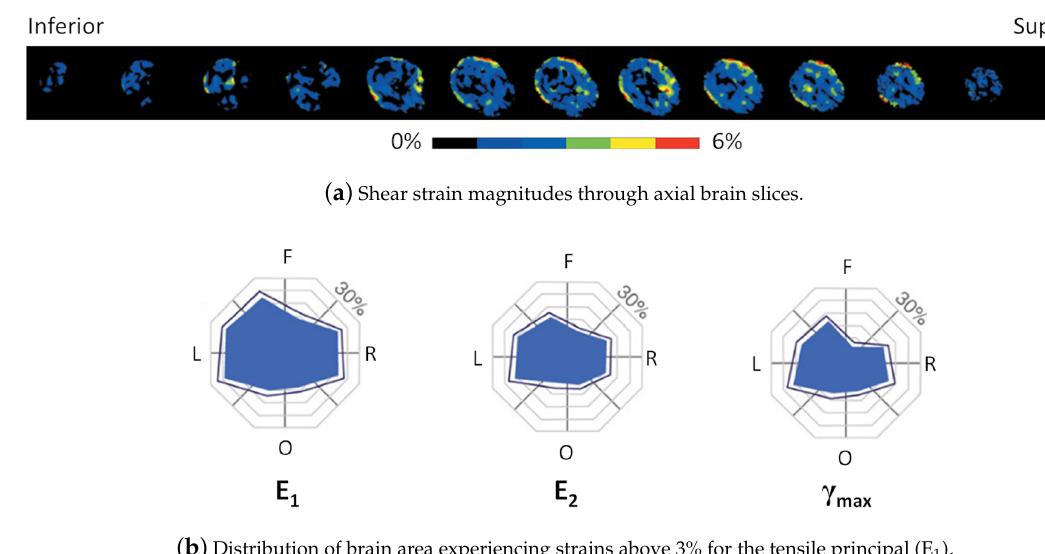
Figure 11. Example of brain strain responses reported by Chan et al. [60], 54 ms after volunteer trigger release. ( a ) Maximum recorded shear strains through 13 axial brain slices moving from inferior to superior regions. The superior most slice does not register any strains above 1% so appears blank. ( b ) Distribution of the area fraction of the brain experiencing strains above 3% for each of the tensile principal (E 1 ), compressive principal (E 2 ) and shear ( γ max ) strains. The shaded area indicates the mean proportion across the cohort of volunteers, with the confidence interval indicated via the bordering line. The spiderplot is orientated with the frontal region of the brain (F) at the top, occipital (O) bottom and left (L) and right (R) as indicated. The segments between represent the temporal and parietal regions